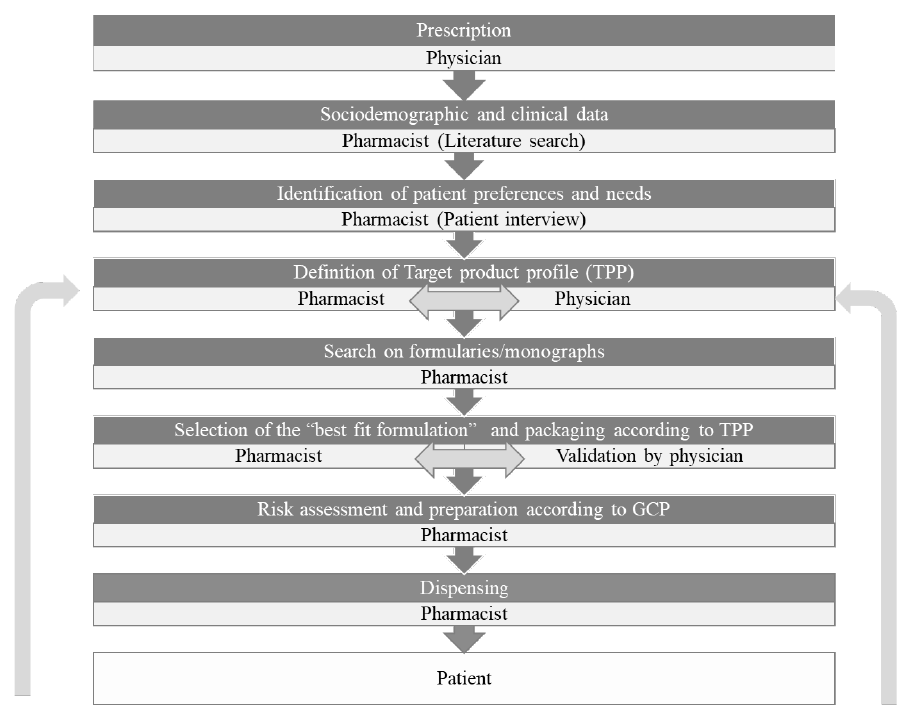
Figure 3. The process of patient-centric drug product design (PCDPD) applied to compounding formulations: Patient-centric compounding design (PCCD).